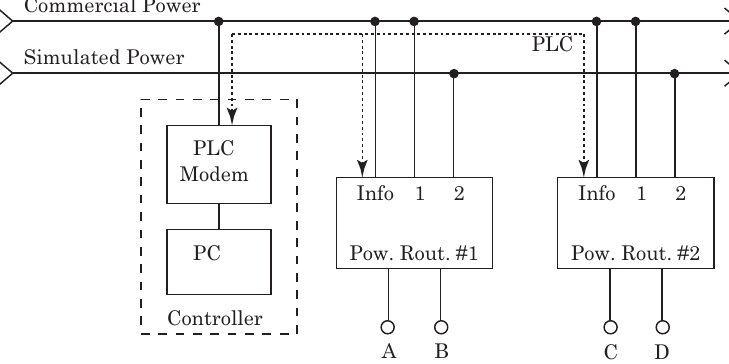
Figure 6. Schematic diagram of a system in parallel